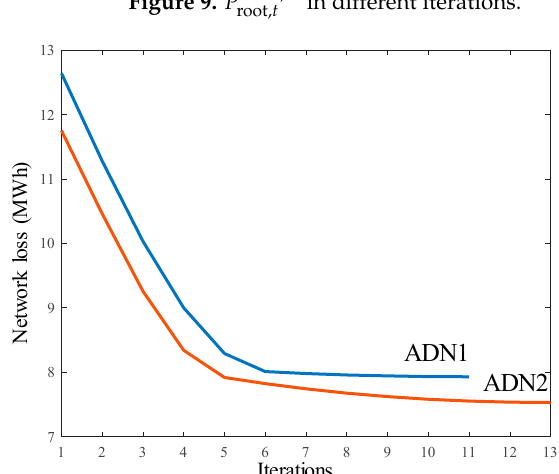
P in different iterations. Figure 9. ADN, F root, t Figure 9. P ADN, F in different iterations. root, t